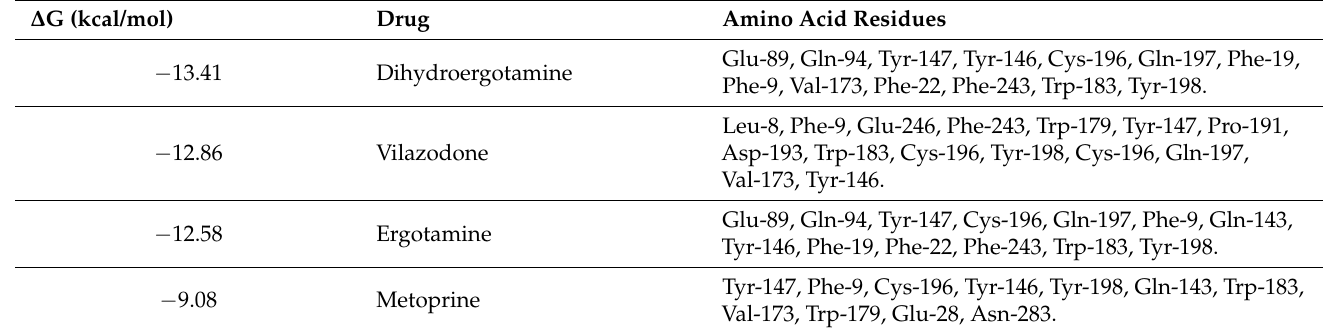
Table 1. FDA-approved drugs with the lowest Gibbs free energy ( ∆ G) to HNMT and the amino acid residues which drives their interaction, obtained by rigid docking studies. Metoprine was included as a reference